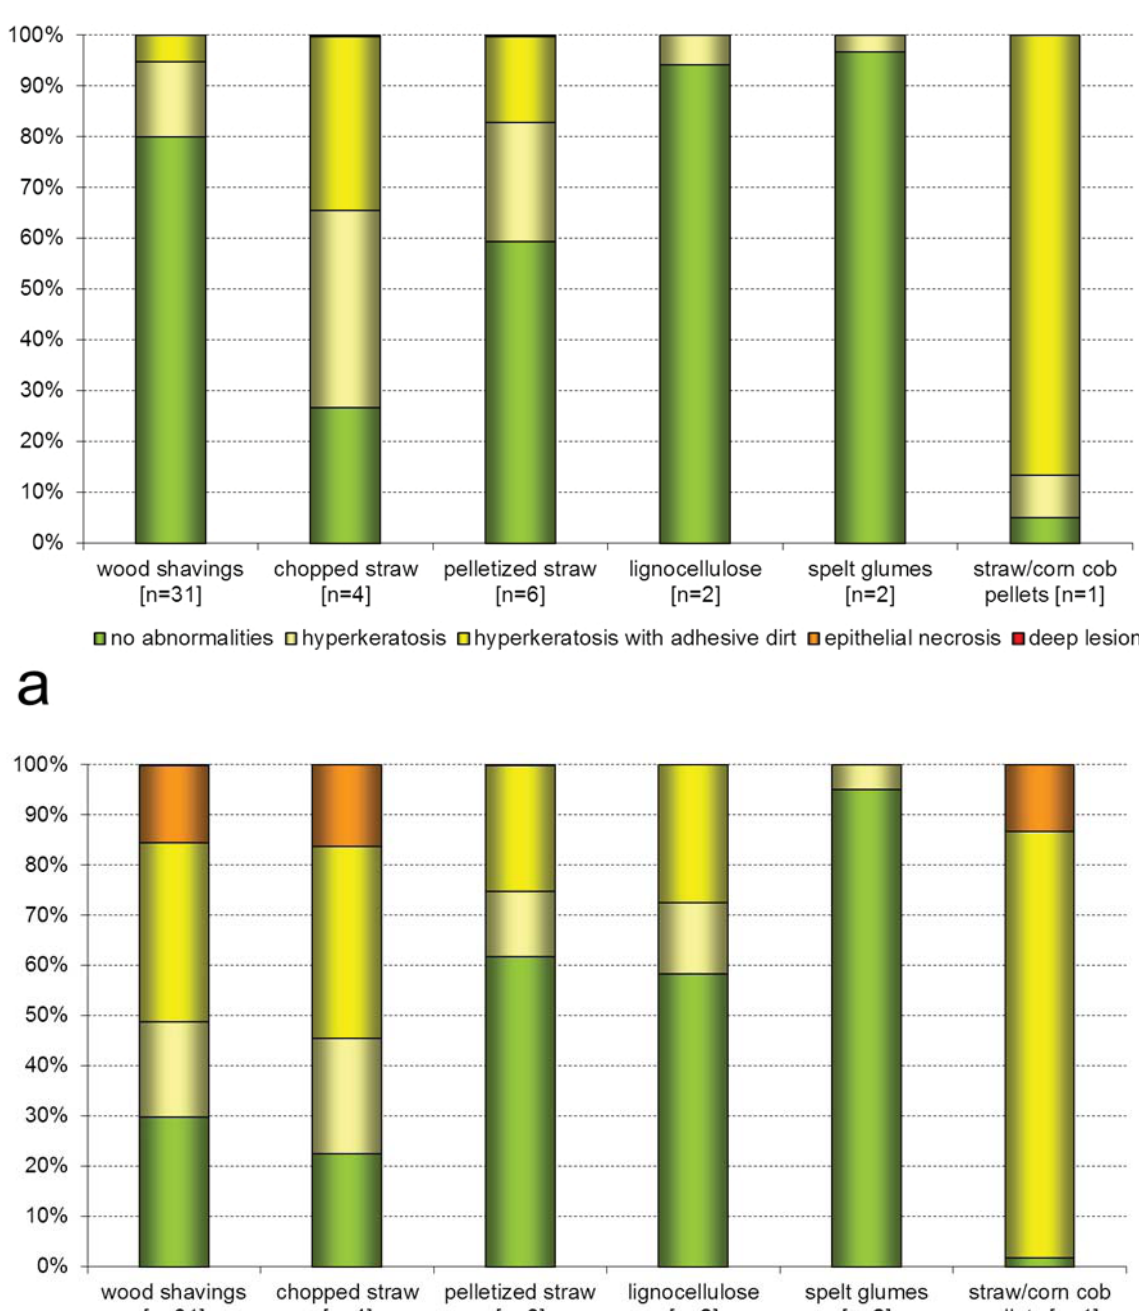
Figure 7. Prevalence of foot pad alterations according to the litter material. ( a ) Day 3 to 5. ( b ) Day 22 to 35. Mean